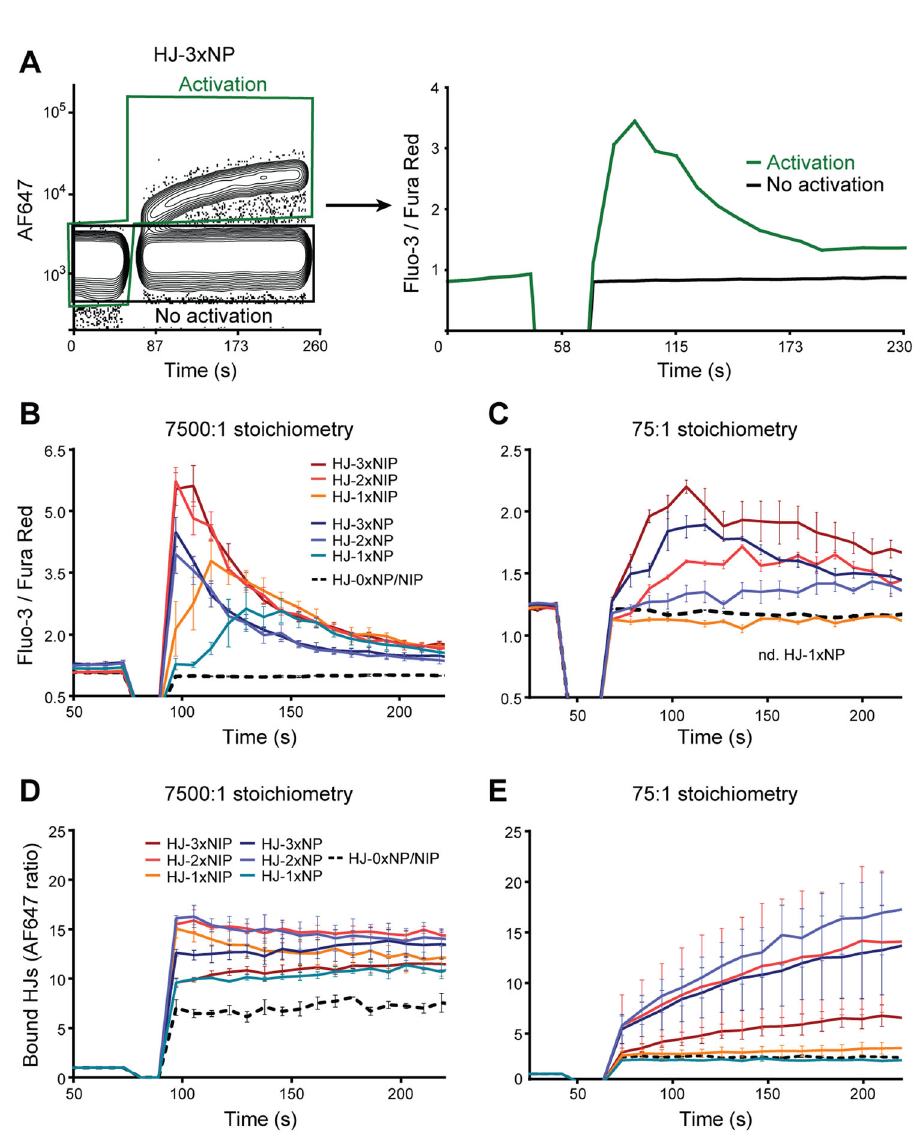
Fig. 4 | Activation of B1-8hi B cells with HJ constructs. A B1-8hi B-cell activation wasstudiedintermsofcalcium fl uxby fl owcytometry.Left,bindingofHJfollowed byAF647signal.Right,calcium fl uxofcellsuponstimulationwithHJ-3xNPintheHJ binding (activation) vs. non-binding (no activation, i.e., background) population. B HJ constructs with various valencies (0, 1, 2 or 3) of two types of haptens (NP or